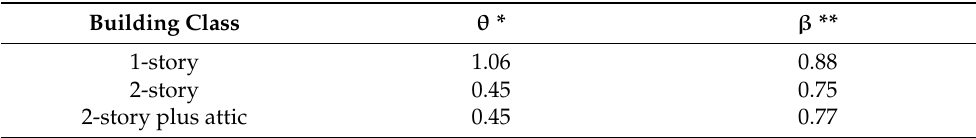
Figure 15. Illustration of volume loss using Building 2 (adapted from Okada [50]). Table 5. Fatality vulnerability parameters for adobe